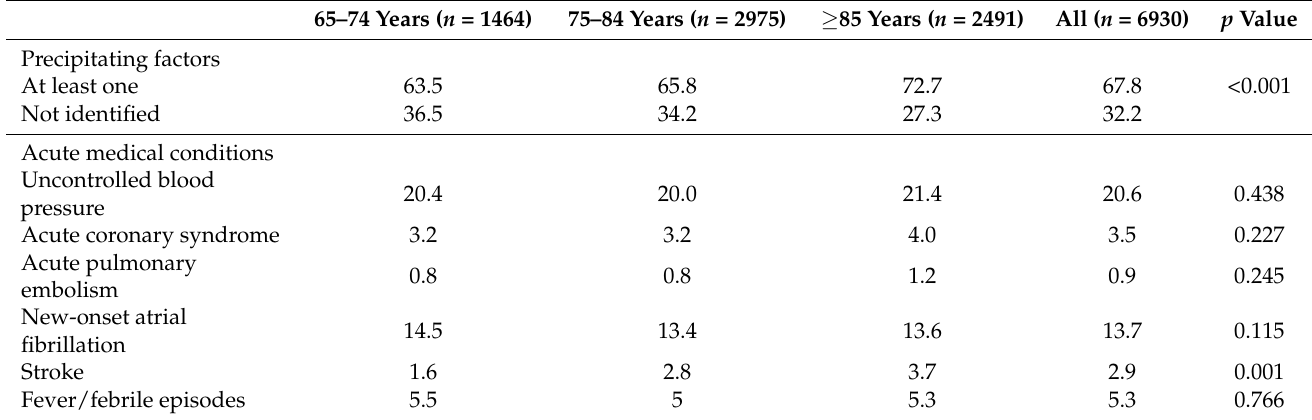
Table 2. Precipitating factors and acute medical conditions by age